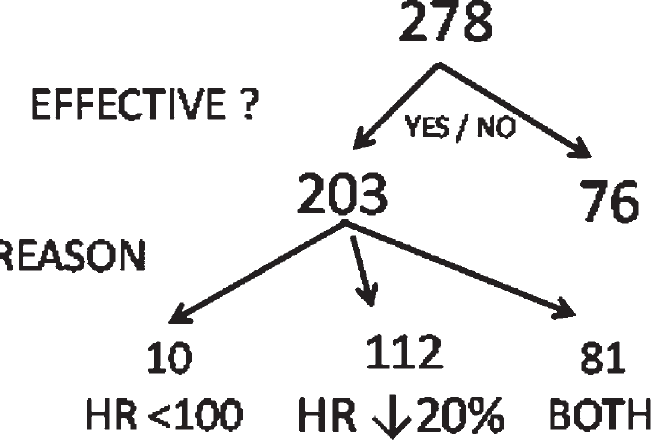
Figure 3. Efficacy of diltiazem. HR , heart